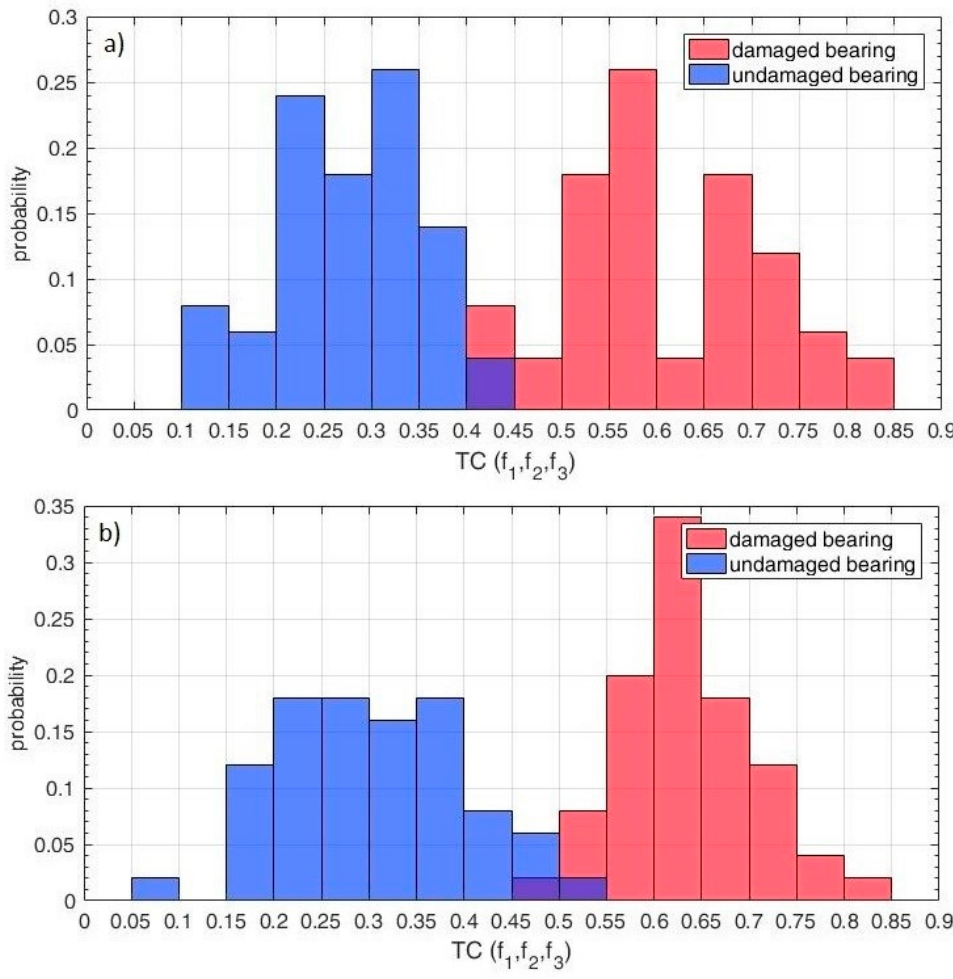
Figure 5. The histograms of the magnitudes of triple correlation (TC) for 5-s ( a ) and for 5.75-s ( b ) time windows.